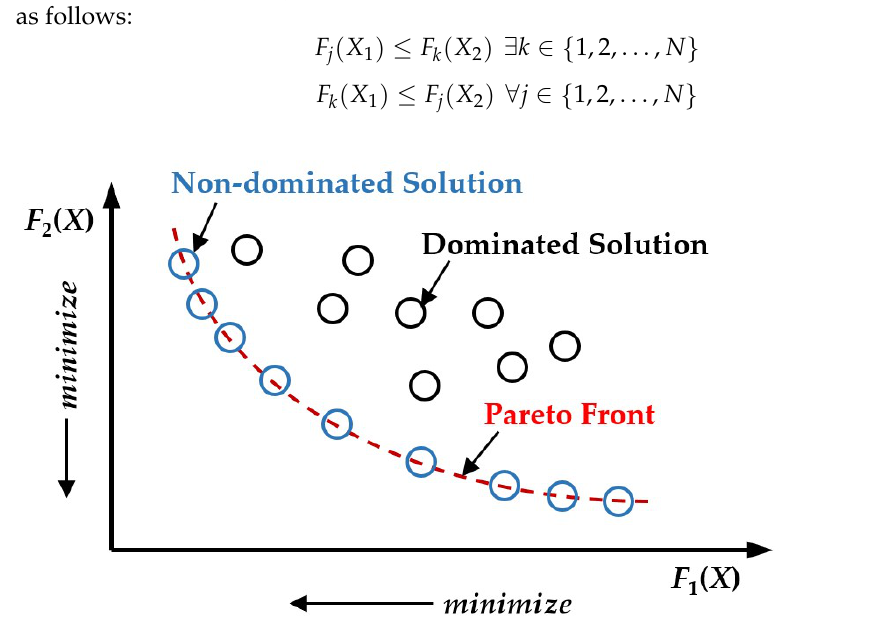
Figure 10. Sample Pareto front solution set for